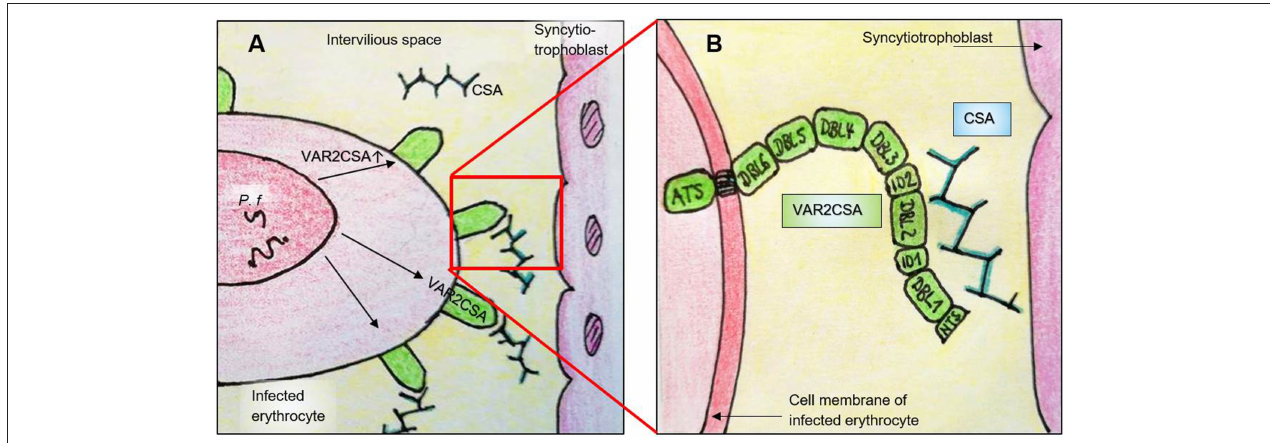
FIGURE 2 | Simplified illustration of the interaction between VAR2CSA and CSA in the placenta. (A) P. falciparum expresses VAR2CSA on the surface of infected erythrocytes, which in turn binds to CSA in the intervillous space. Pf, P. falciparum within a parasitophorous vacuole; CSA, chondroitin sulfate A. (B) Enlarged view of (A) . VAR2CSA binds to CSA with its N-terminal domains. ATS, Acidic terminal segment; DBL, Duffy-binding-like domain; ID, Interdomain; NTS, N-terminal segment.